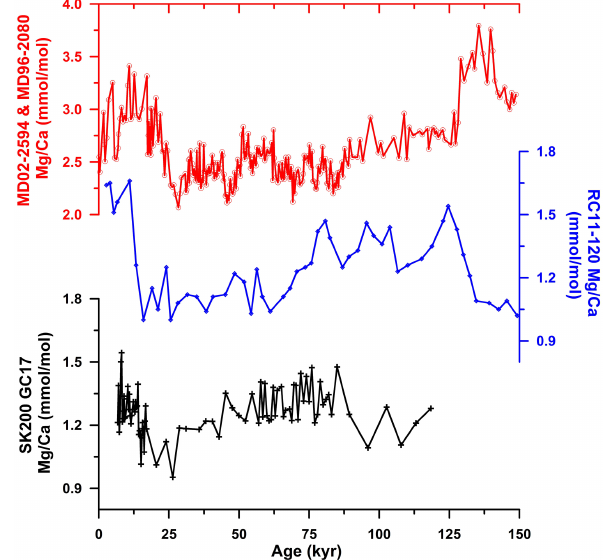
Fig. 4. A comparison of Globigerina bulloides Mg/Ca in core SK 200 GC17 with that in RC11-120 which was collected from southeastern Indian Ocean (Mashiotta et al., 1999) and MD02-2594 and MD96-2080 (Martínez-Méndez et al., 2010). The Mg/Ca scale ( y axis) is the same for SK 200 GC17 and